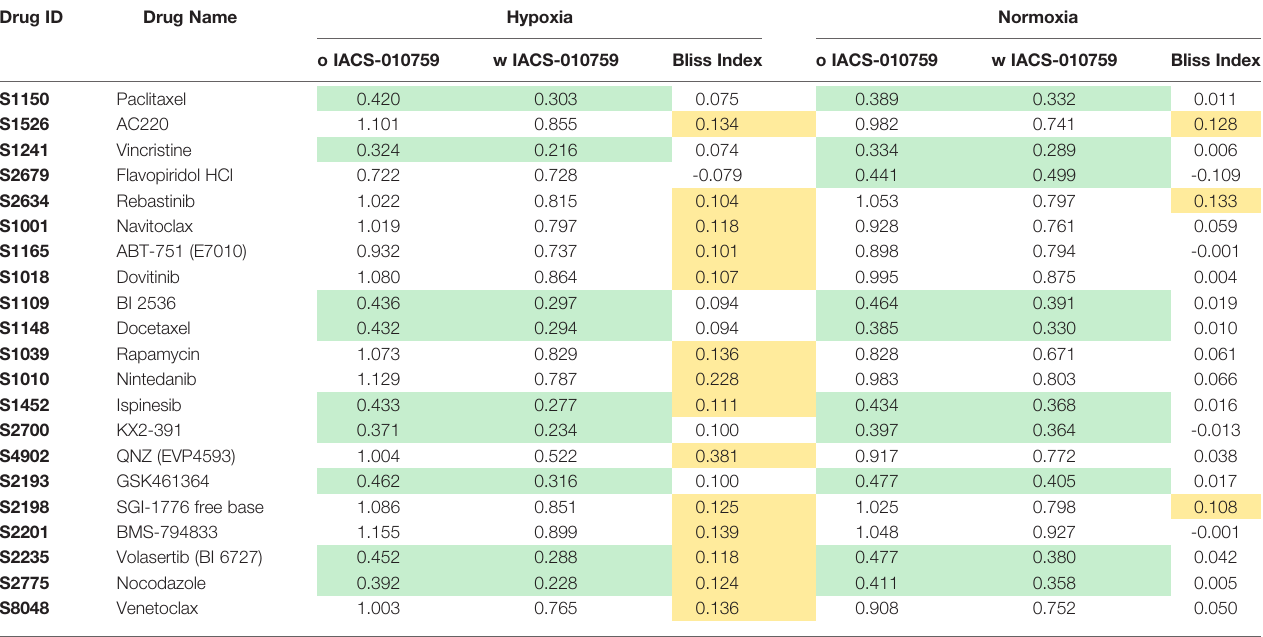
TABLE 1 | The relative cell viability and Bliss index of OCI-AML3 treated by 21 selected drugs in combination with IACS-010759 from the primary screening in both hypoxia and normoxia conditions. Drug ID